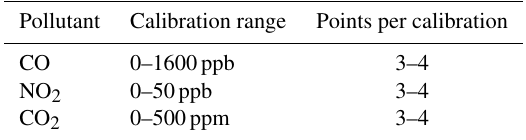
Table 1. Calibration ranges for laboratory-based calibration (LAB). Pollutant Calibration